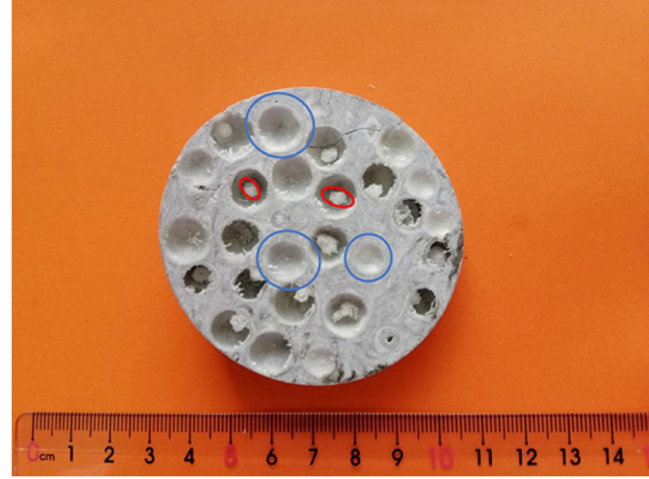
Figure 5. The cross section of the ESF.